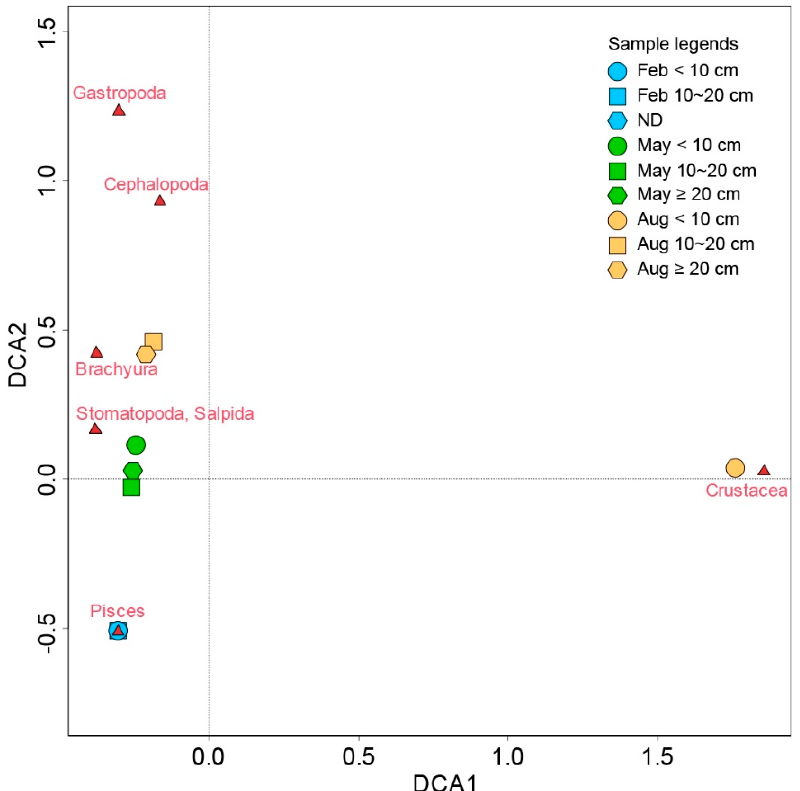
Figure 3. Bi-plot of detrended correspondence analysis (DCA) derived from consumer species and their dietary compositions in a reduced space. Red triangles represent prey items. Circles, squares, and hexagons represent common squid Todarodes pacificus in the South Sea of Korea during February (blue), May (green), and August (yellow) 2021.